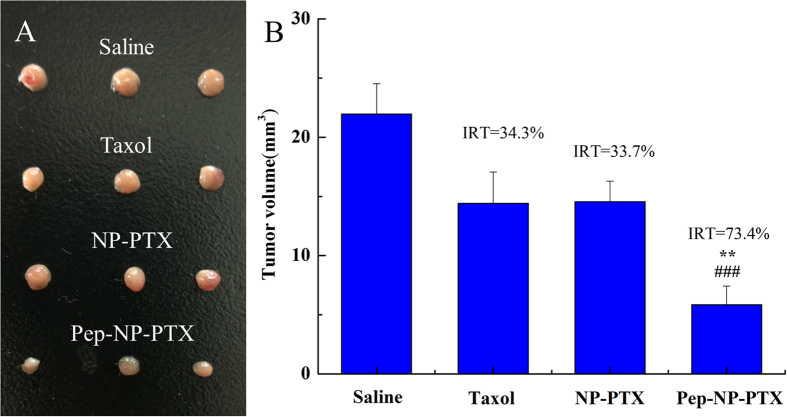
Photograph of glioma from each treatment group excised on day 14 post-implantation (A); the glioma volume of each treatment group at the time of sacrifice. IRT: inhibition ratio of tumor (%) (B). **p < 0.01 significantly higher than that of Taxol®, ###p < 0.001 significantly higher than that of NP-PTX.